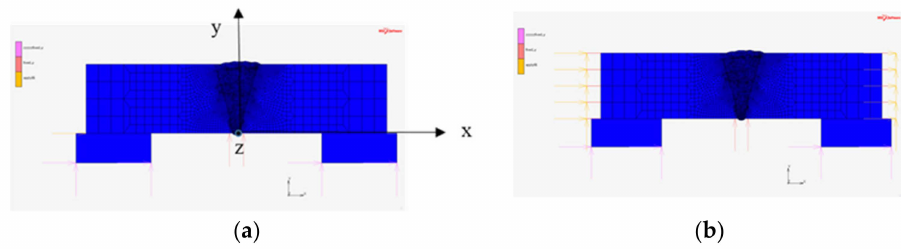
Figure 9. Restraint analysis model for a thickness of 70 mm: ( a ) free, spring stiffness K s = 0 MPa/mm and ( b ) spring stiffness K s = 100, 200, and 300 MPa/mm.